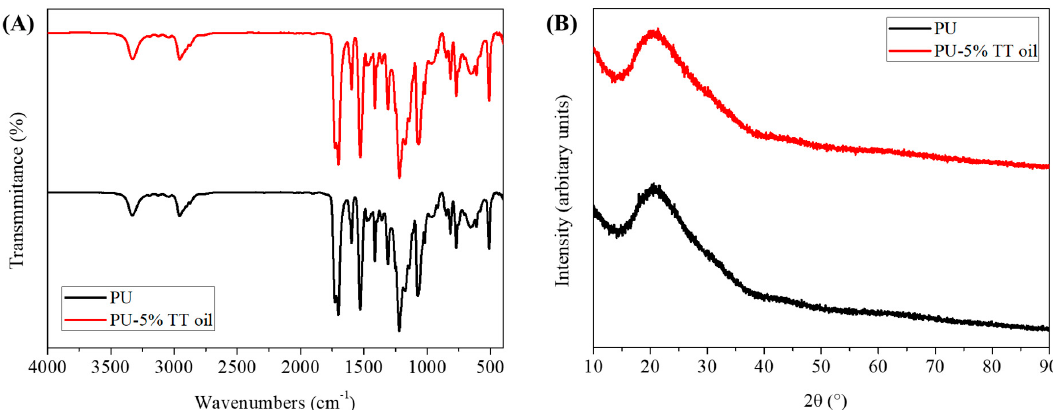
Figure 2. ( A ) Fourier transform infrared spectroscopy (FTIR) spectra and ( B ) X-ray diffraction (XRD) patterns of the PU and PU-5% TT oil.